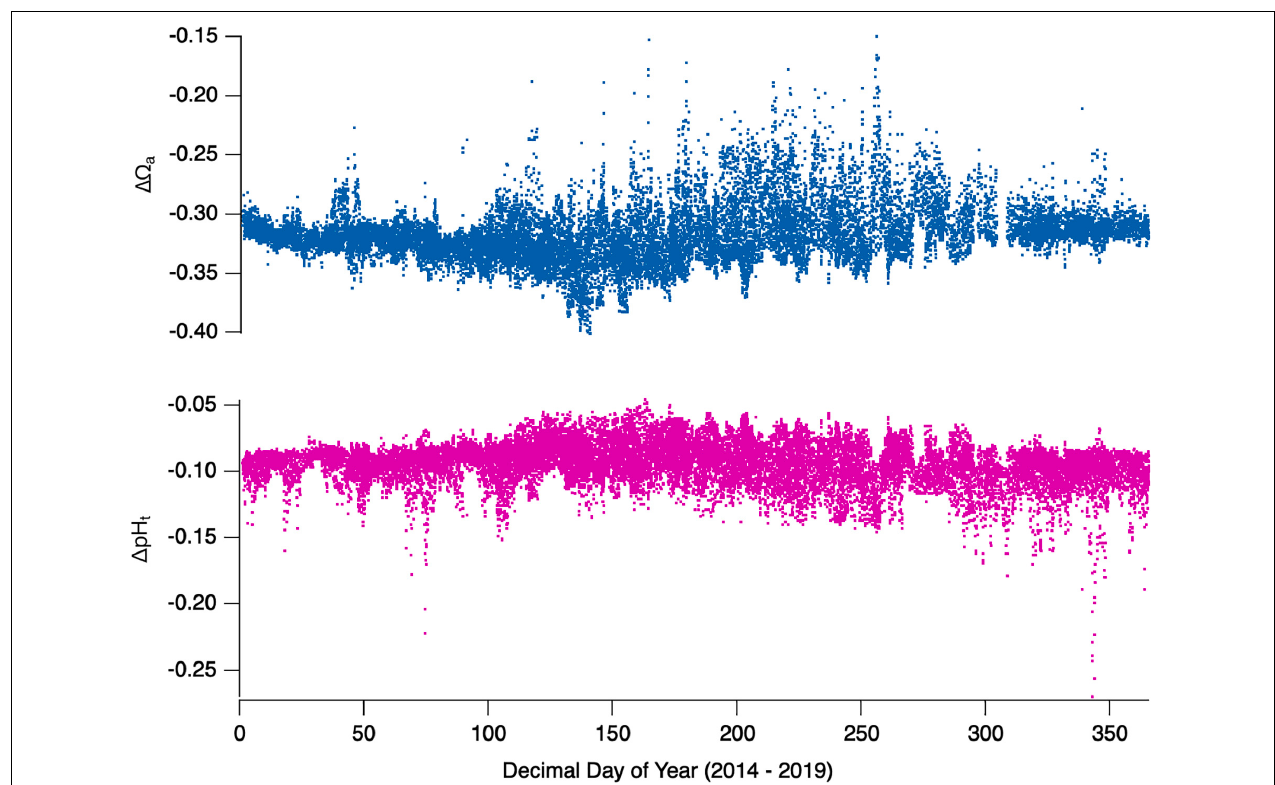
FIGURE 9 | (cid:49)(cid:127) a (top) and (cid:49) pH t (bottom) calculated for all years 2014–2019 at WCSH using a conservative nominal value of 37 µ mol/kg TCO 2 added to west coast of United States surface water since 1850. Values represent approximate negative departures due to anthropogenic CO 2 .